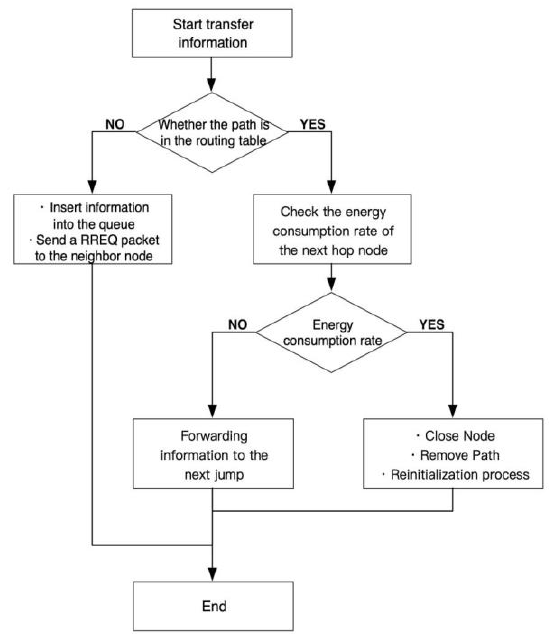
Figure 7. Steps of the AODV energy-aware routing protocol.